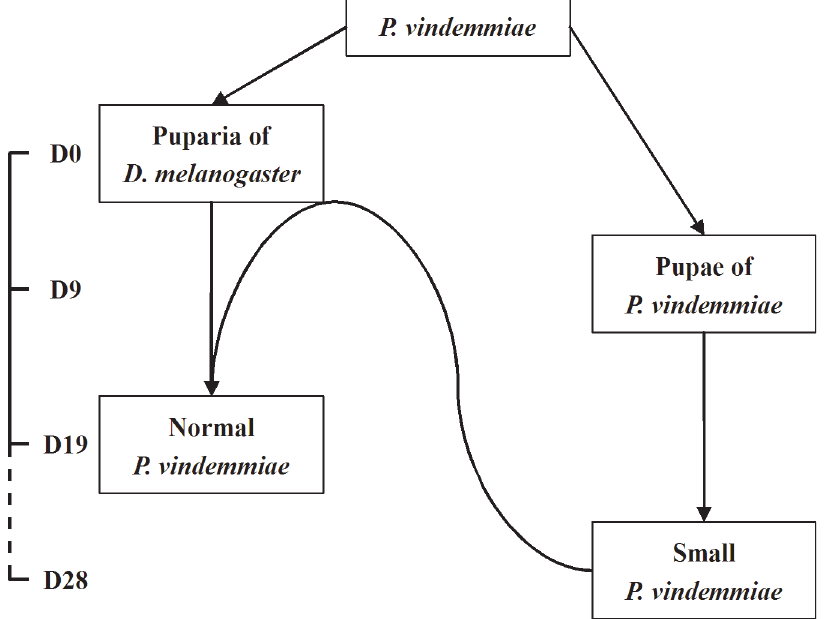
Fig 6. Facultative hyperparasitism of P . vindemmiae on conspecifics. D0-D28 indicate days after the primary parasitism. When healthy Drosophila puparia were lacking, those with primary conspecifics could be used and small parasitoid offspring occurred, but the emergence of the parasitoid delay for about nine days, and the risk of host limitation could be partly relieved. When healthy puparia were available, the smaller foundresses from the conspecific hyperparasitism laid eggs and normal progeny